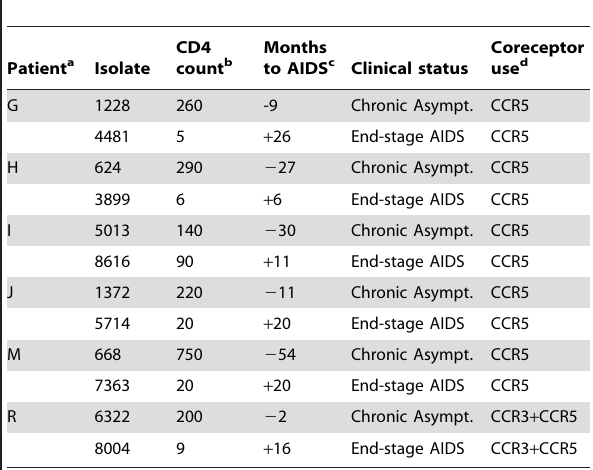
Table 1. Patient clinical status, CD4 count and virus coreceptor